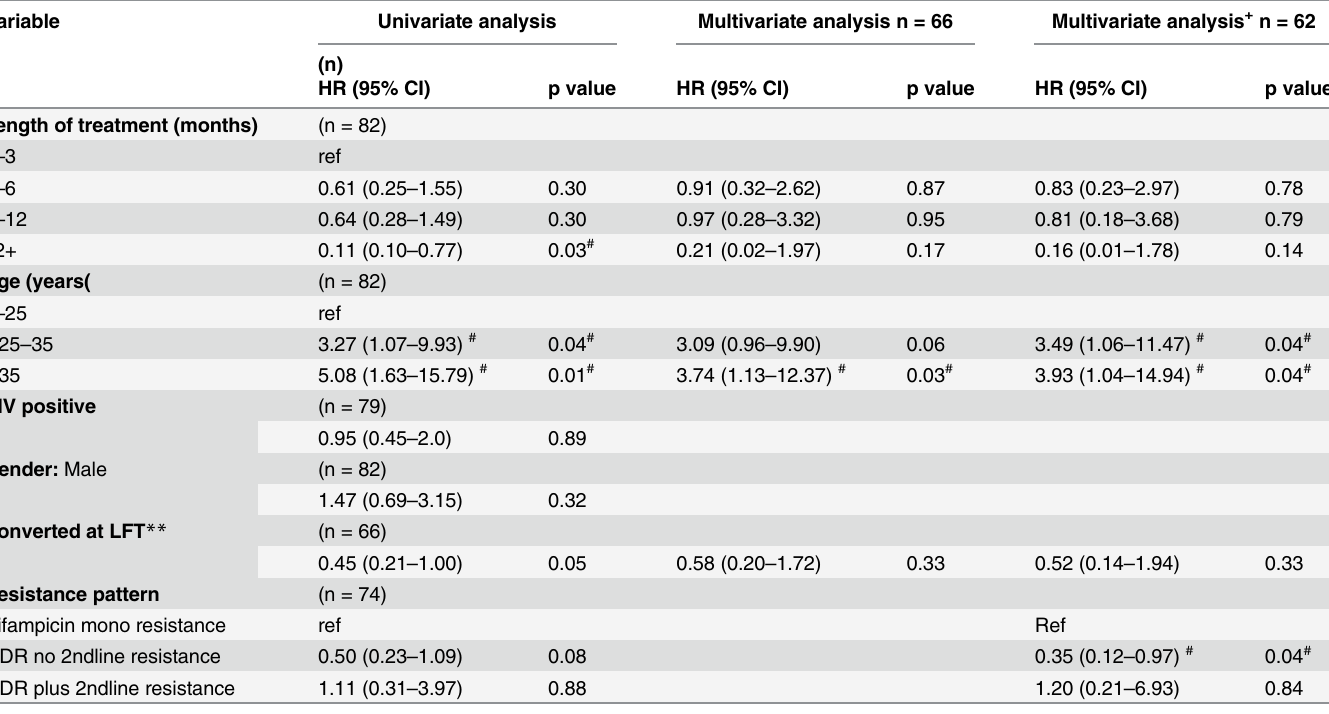
Table 3. Survival post treatment: Factors associated with time to mortality post treatment.